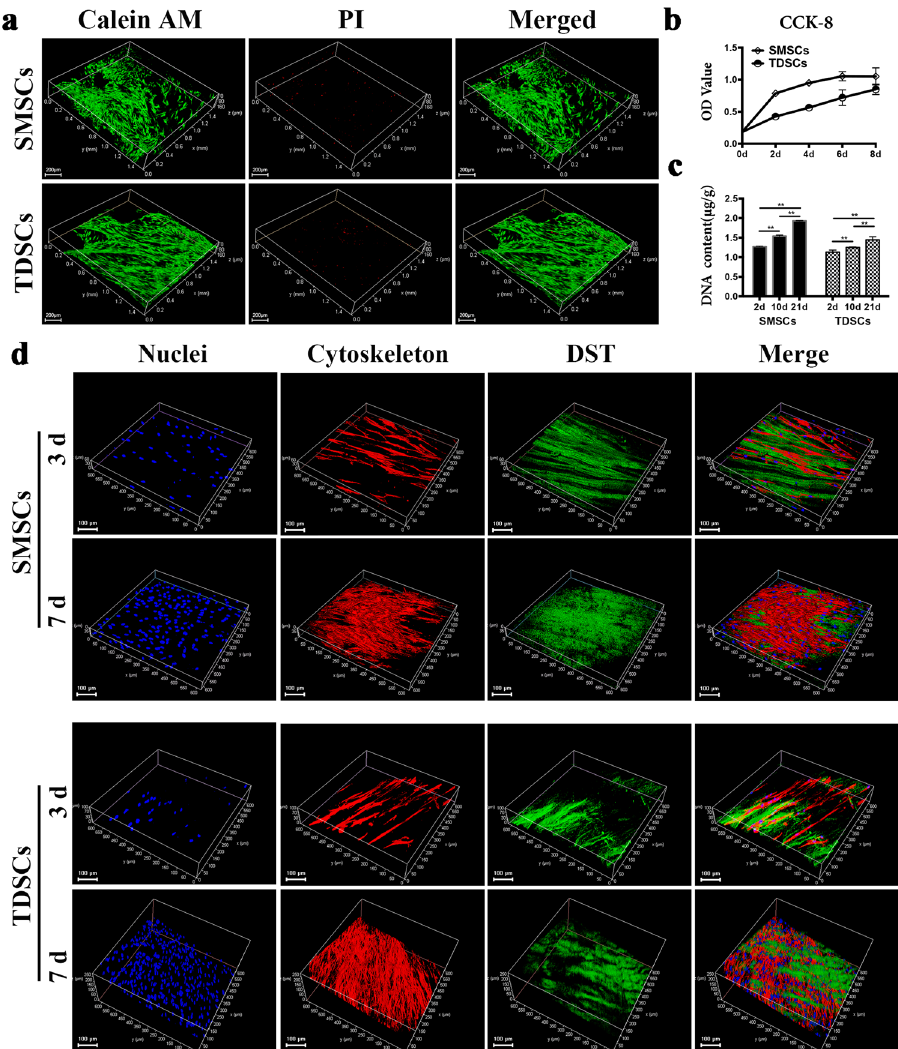
Figure 2. Viability, proliferation and morphology of SMSCs and TDSCs in DSTs in vitro . ( a ) LIVE/DEAD staining analysis of SMSCs and TDSCs seeded in DSTs after 7 days by fluorescence microscopy, with live cells stained green (calcein AM) and dead cells stained red (PI). Scale bar = 200 μ m. ( b ) OD values of CCK-8 assay of SMSCs and TDSCs cultured in DSTs (n = 3). ( c ) DNA content of SMSCs and TDSCs seeded in DSTs at day 2, 10 and 21 (n = 3, ** p < 0.01). ( d ) Cell morphology of SMSCs and TDSCs seeded in DSTs by fluorescence microscopy, with nuclei stained blue, cytoskeleton stained red and DSTs displayed green. Scale bar = 100 μ